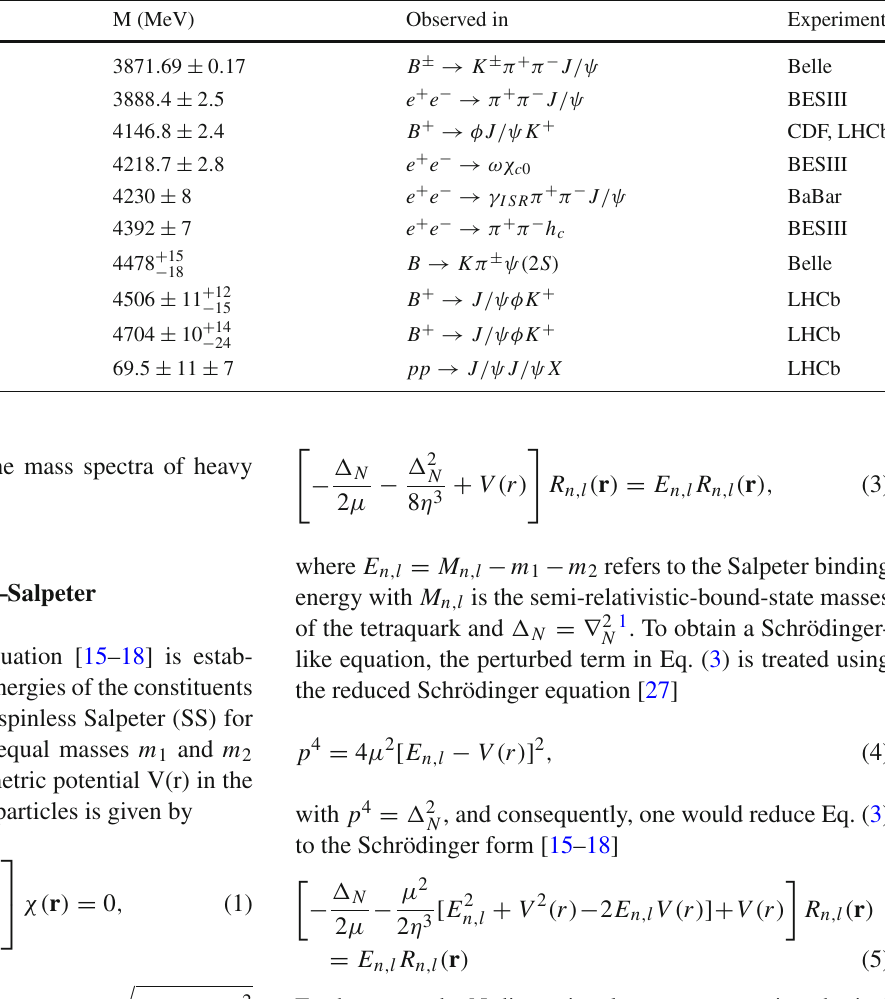
Table 1 Experimental data on hidden-charm exotic mesons State Observed in